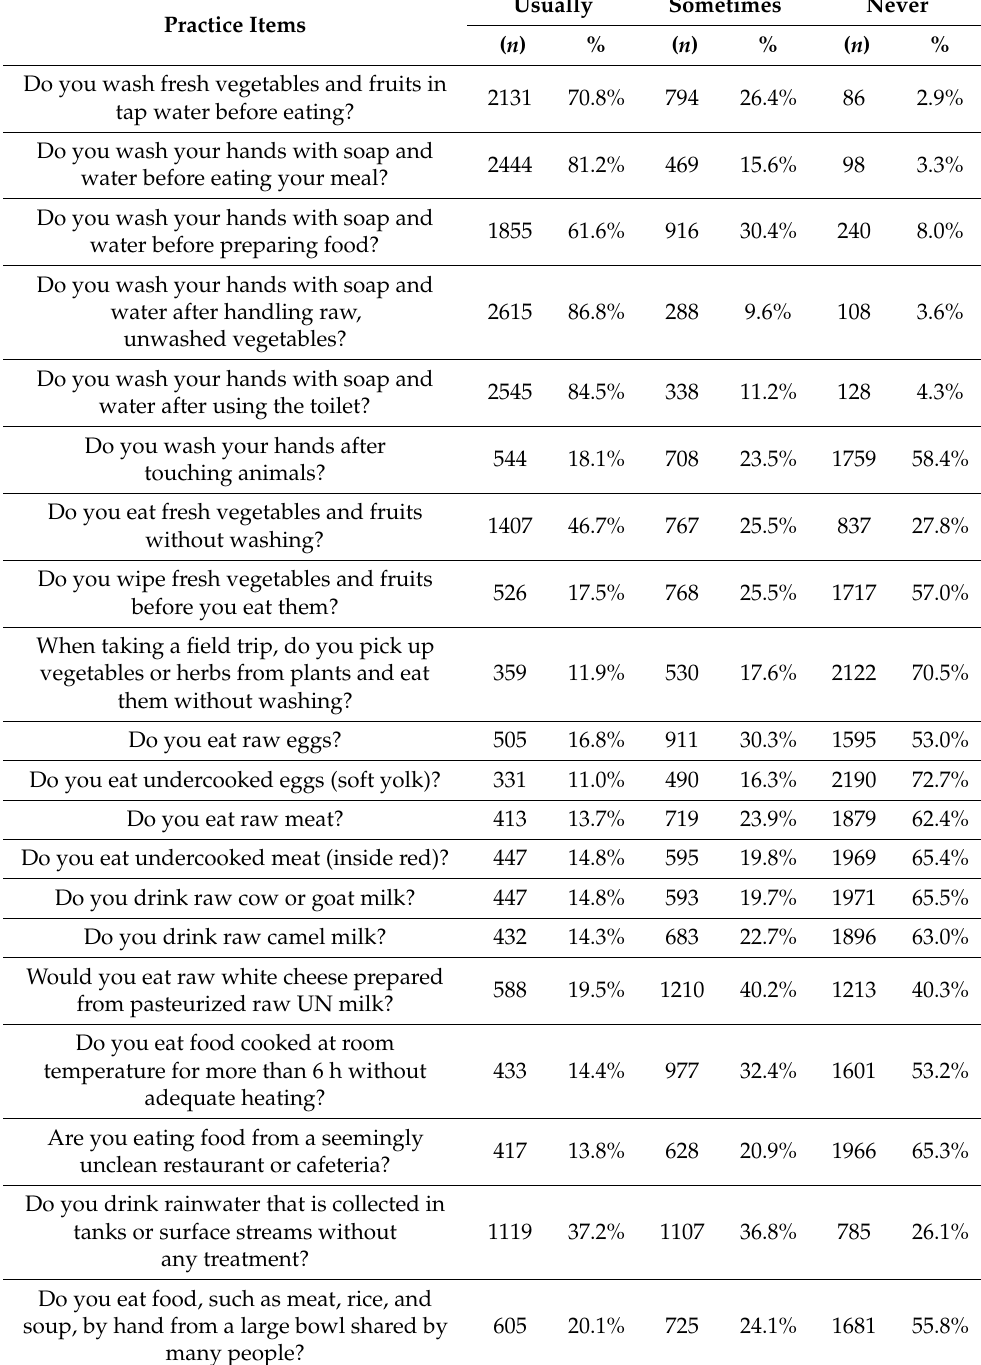
Table 4. Parents’ practices regarding food